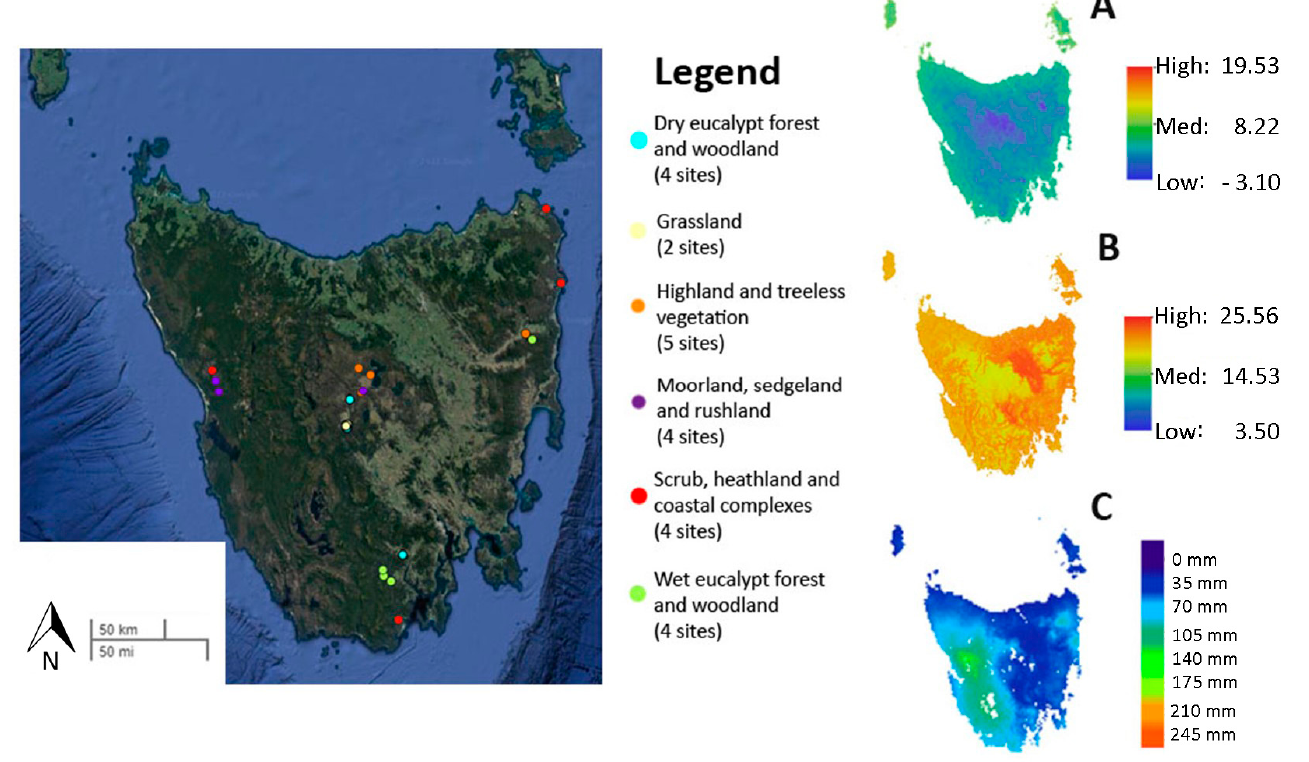
Figure 4. Location of study sites in Tasmania (main), dots indicate a paired (burned and unburned) transect, with colours indicating vegetation type. Inserts are ( A ) mean daily minimum temperature for July (°C), ( B ) mean daily maximum temperature for January (°C), and ( C ) mean precipitation for February, the driest month [52]. Modified and adapted using a creative commons licence 4.0 from [52].